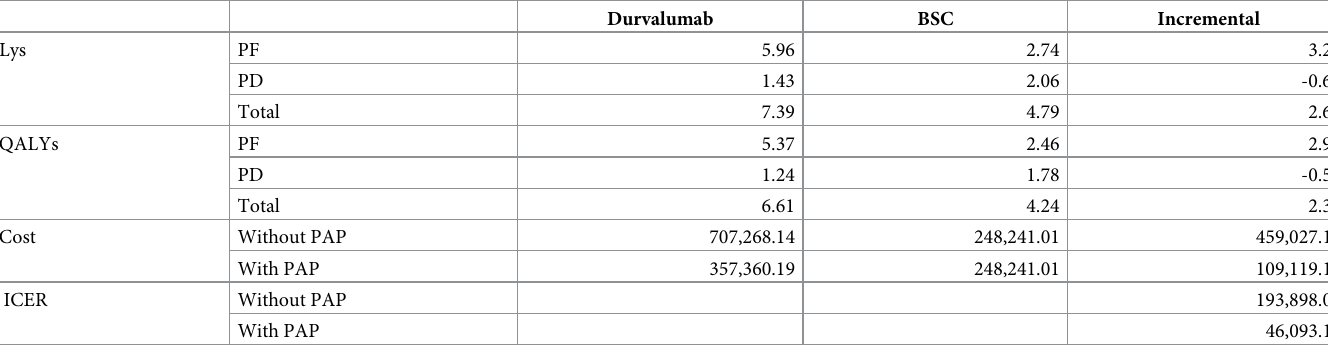
Table 3. Base case results: Discounted cost-effectiveness of